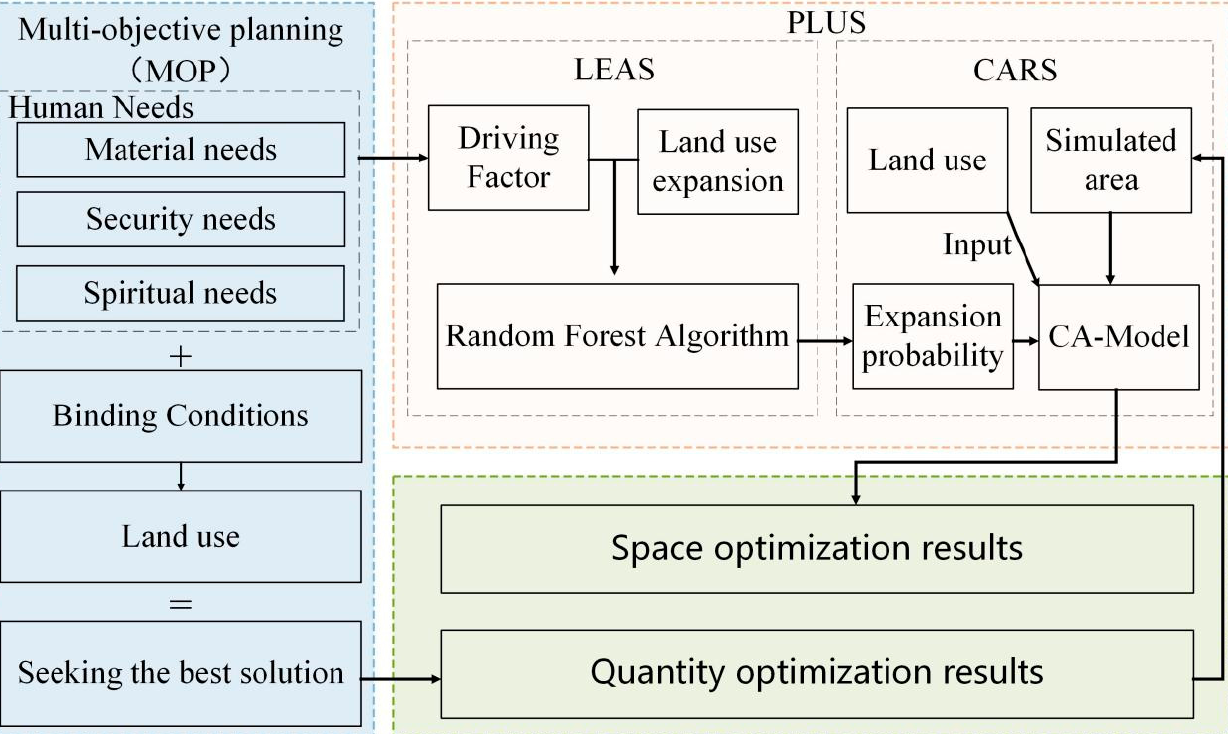
Figure 1. Research idea diagram.